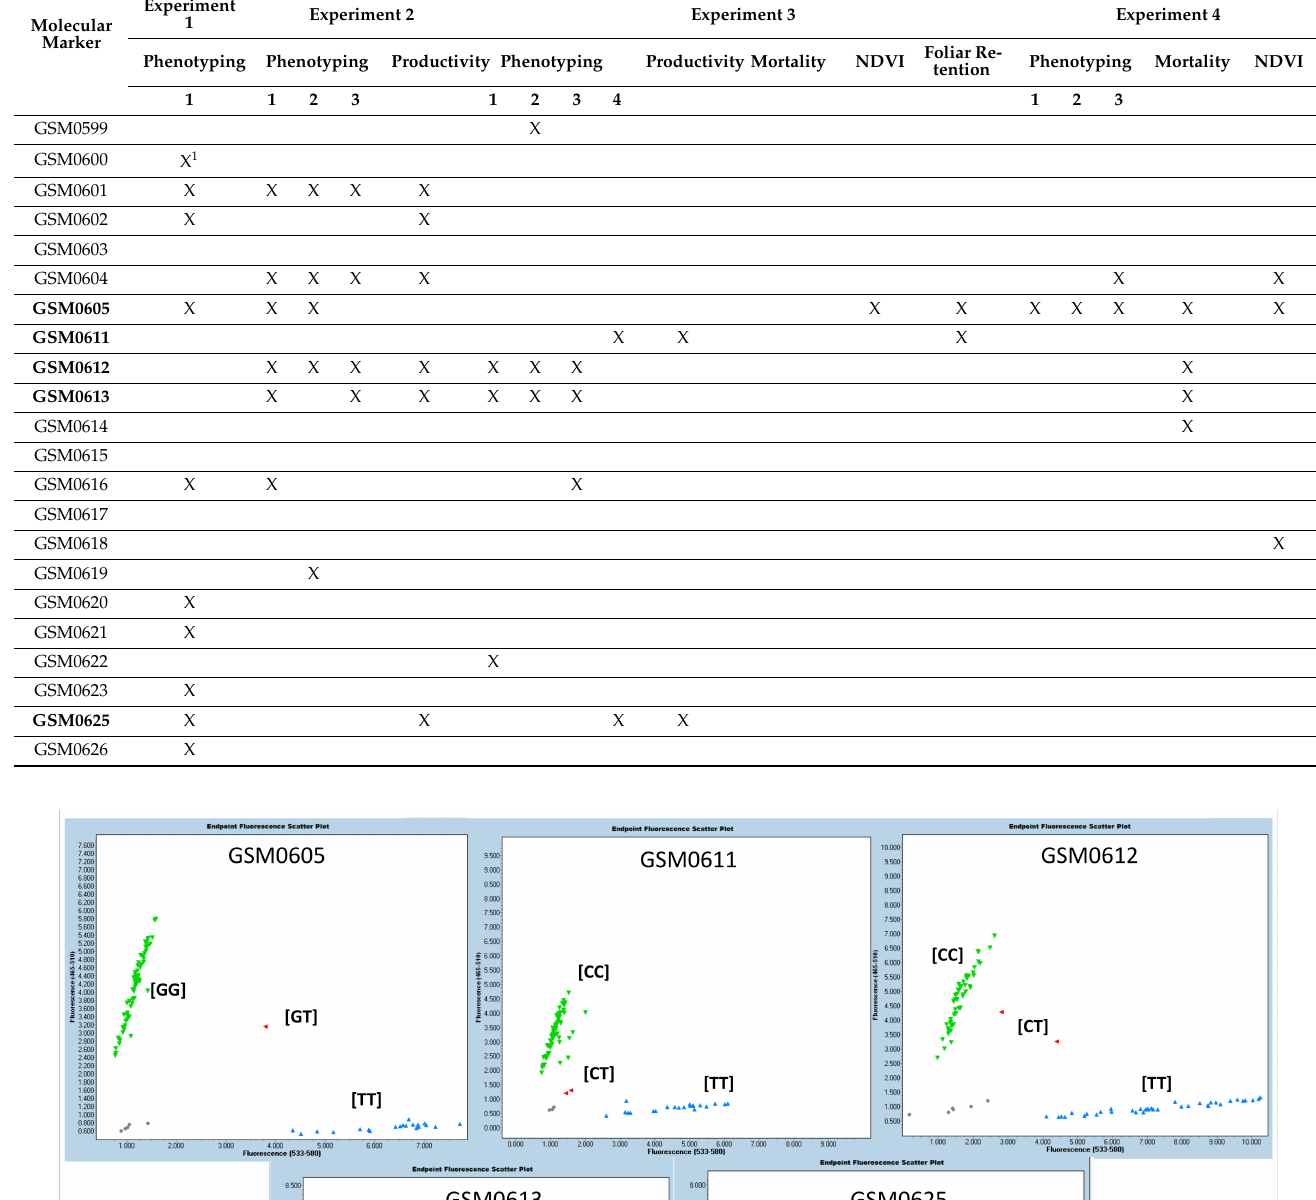
Table 8. Significant correlation between SNP markers and the variables analyzed in each experiment.